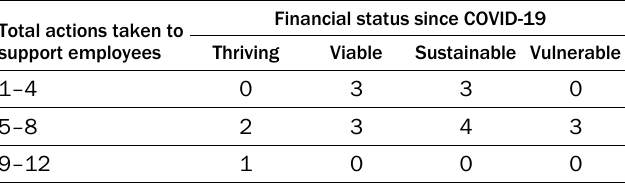
Table 7. Financial Status Since COVID-19 and Total